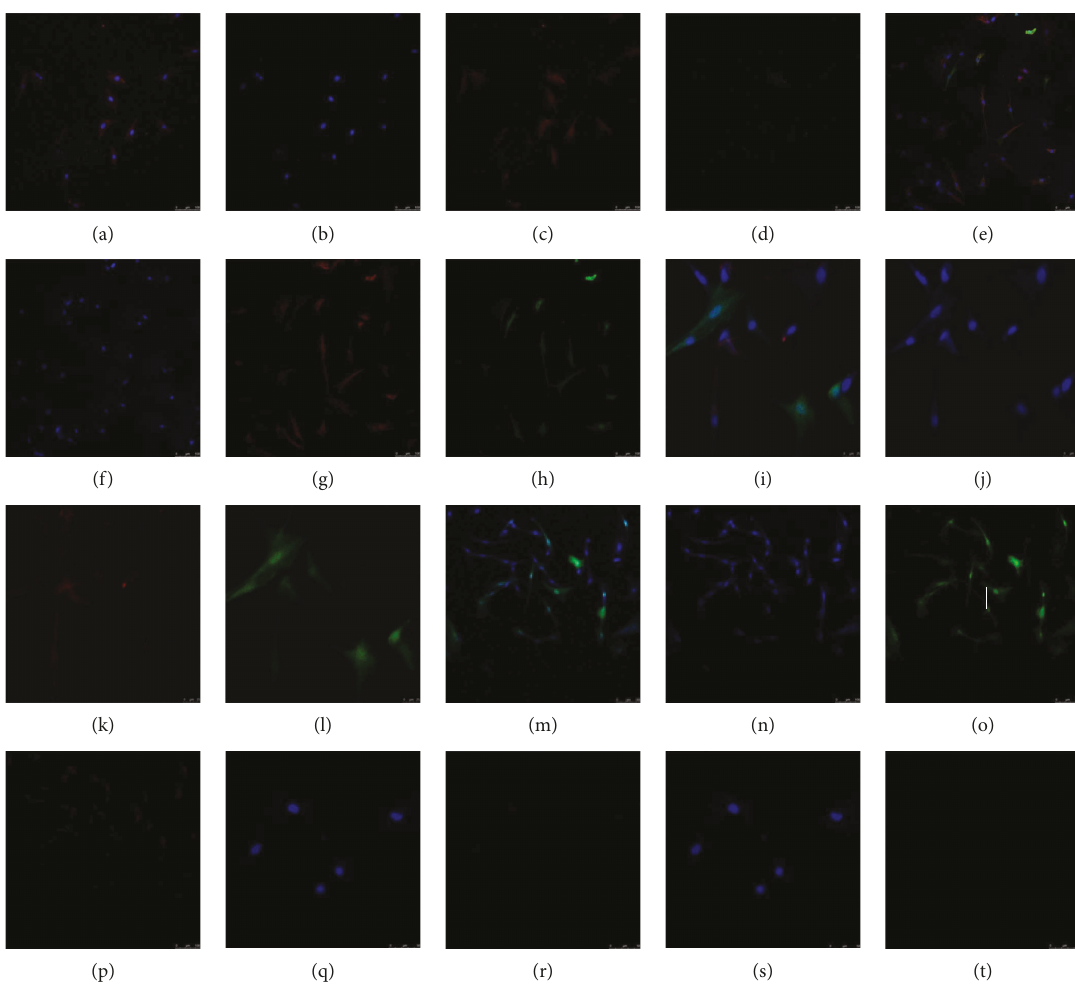
Figure 6: Immuno fl uorescence detection of the myocardium-speci fi c transcription factor GATA in ASCs overexpressing miRNA-1 and cocultured with CMs. Five groups of 3rd-generation lentivirus (Lv)-infected ASCs and/or CMs were examined as follows: (a – d) CMs alone; (e – h) Lv-miR-1-CMs (miRNA-1-expressing ASCs cocultured with CMs); (i – l) Lv-NC-CMs (control infected ASCs cocultured with CMs); (m – p) Lv-miR-1 cells (miRNA-1-expressing ASCs); (q – t) ASCs alone. (a, e, i, m, and q) Merged images; (b, f, j, n, and r) DAPI fl uorescence stain; (c, g, k, o, and s) GFP, indicating ASC fl uorescence labeling; (d, h, l, p and t) red fl uorescence, indicating